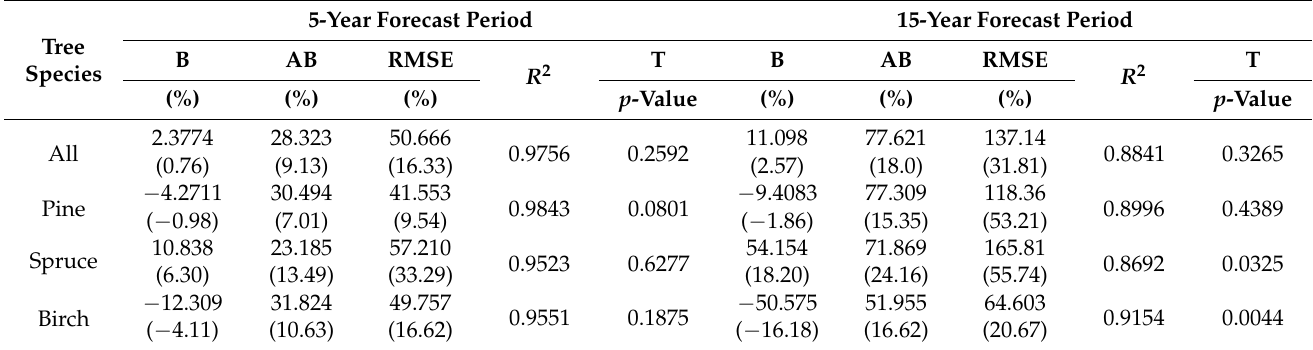
Table 9. Statistical measures and p -values of the Student’s t -test for the forecasts of the tree basal area (individual-tree